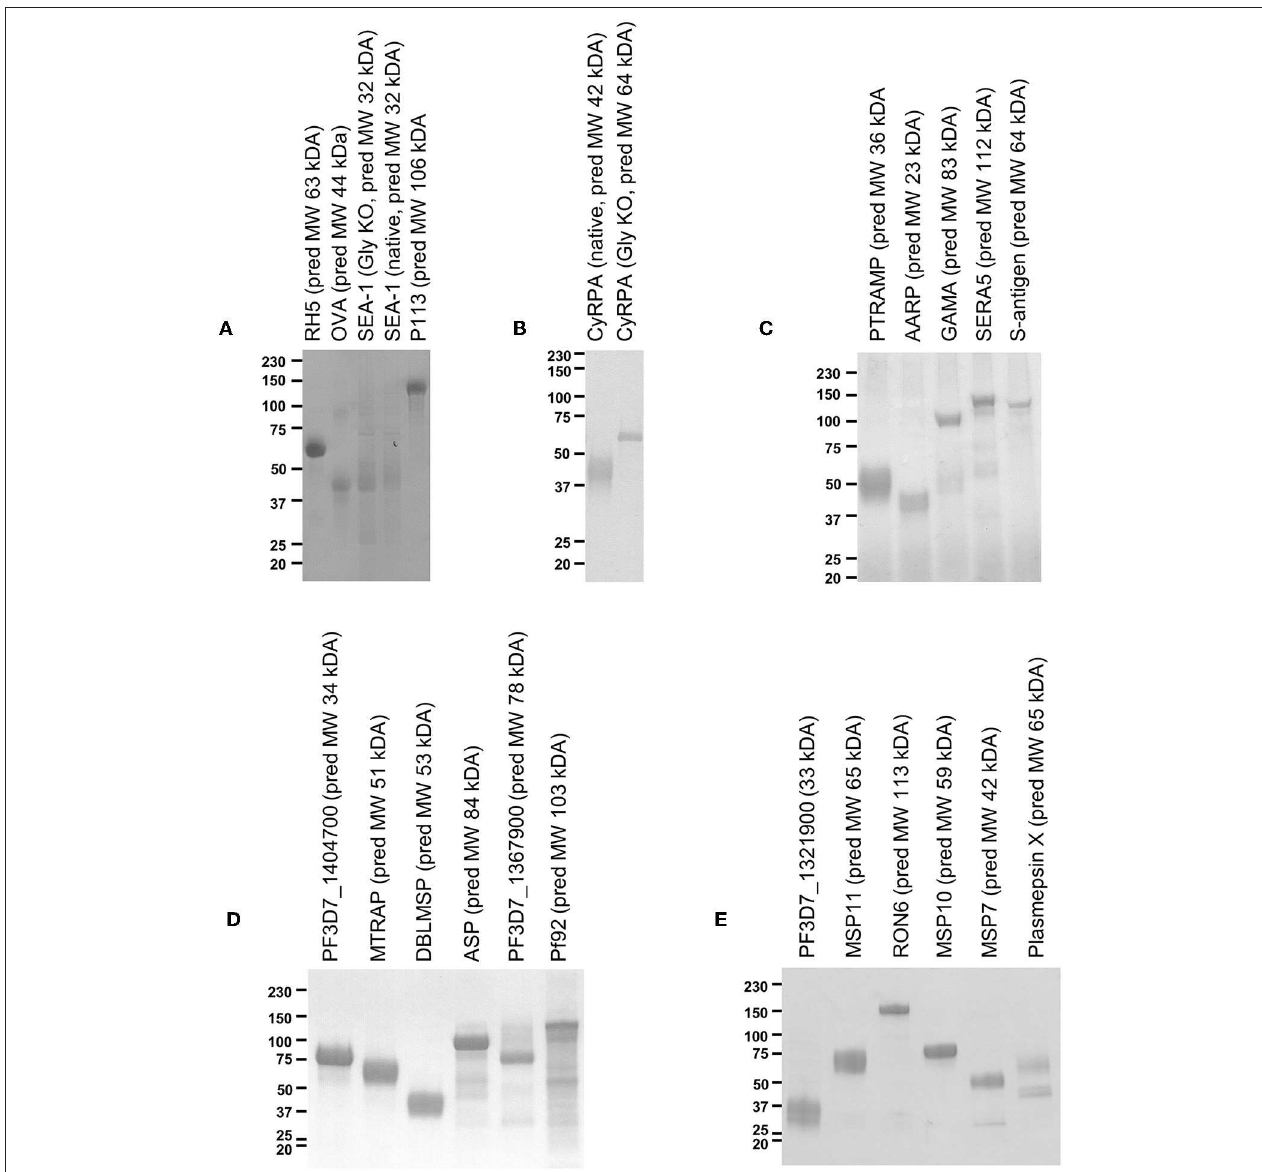
FIGURE 1 | Twenty-two protein antigens representing 20 different P. falciparum proteins. Just prior to formulation with AddaVax TM and immunization into mice, approximately 2 µ g protein was analyzed by reducing SDS-PAGE. Four immunization campaigns were run in total, with (A,B) combined into one campaign, and (C–E) each having their own campaign. (A) also includes analysis of “GIA positive” and “negative” control proteins, RH5, and